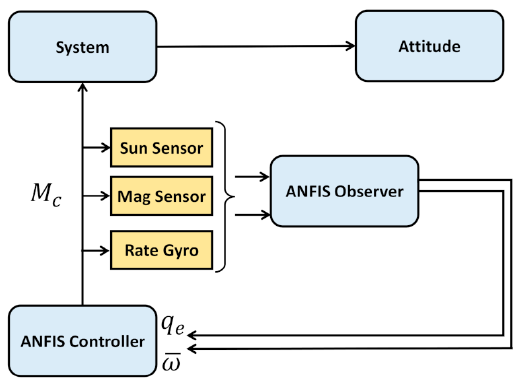
Figure 4. Block diagram of the combined ANFIS observer and controller.